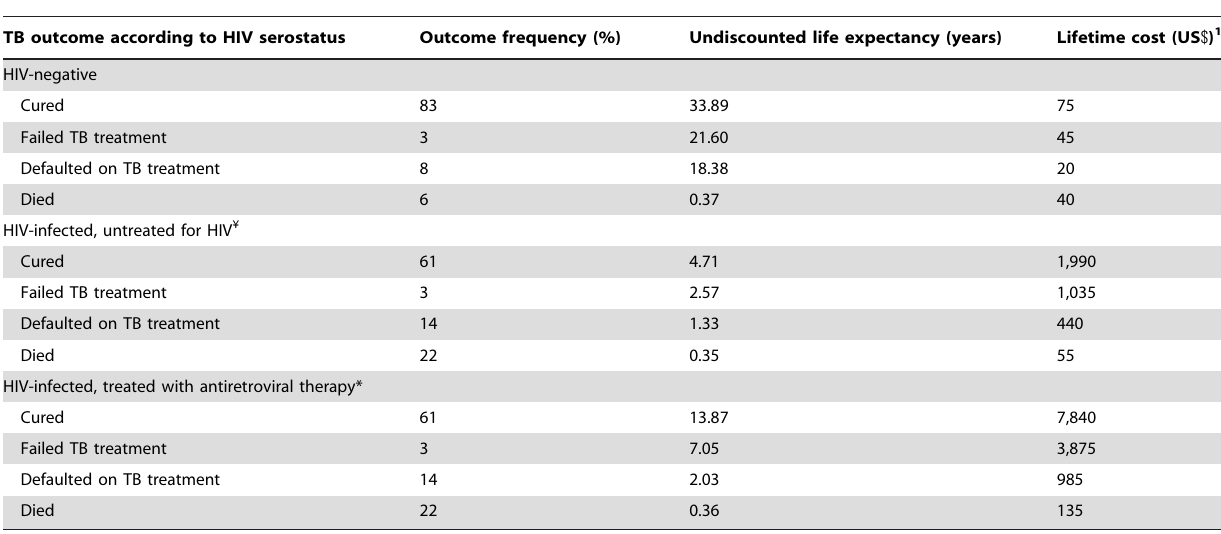
Table 5. Life expectancy and cost outcomes for groups of TB patients in India, stratified by HIV infection and treatment status.